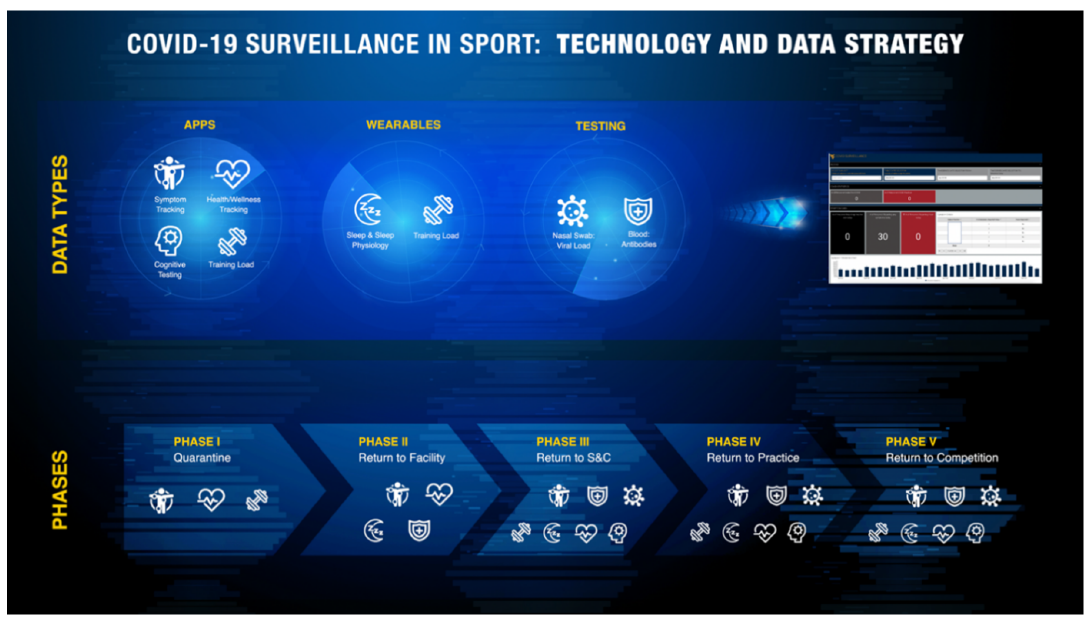
Figure 1. COVID-19 Data Monitoring Strategy.